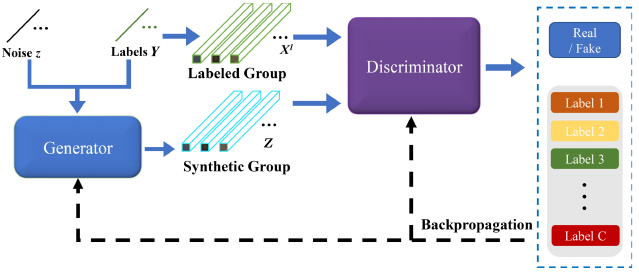
Figure 1. Architecture of ACGAN for HSI classification